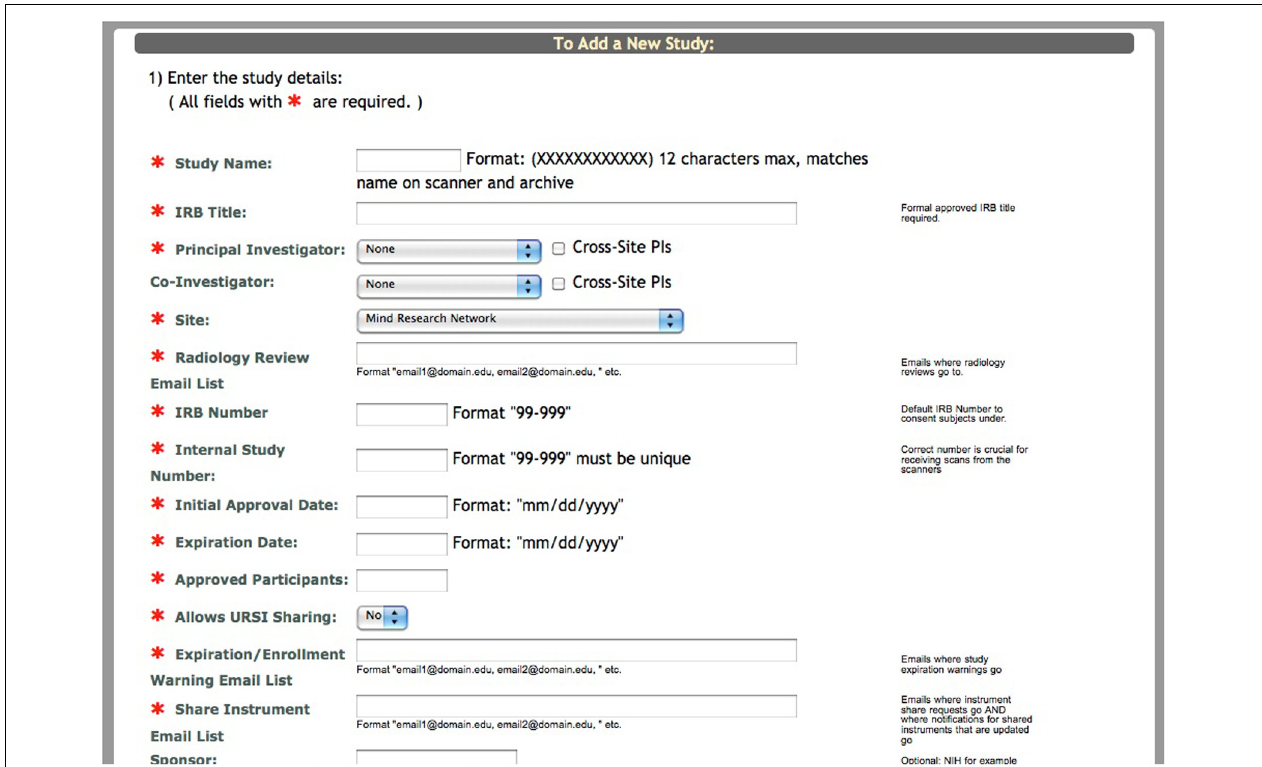
FIGURE 1 | Add a new